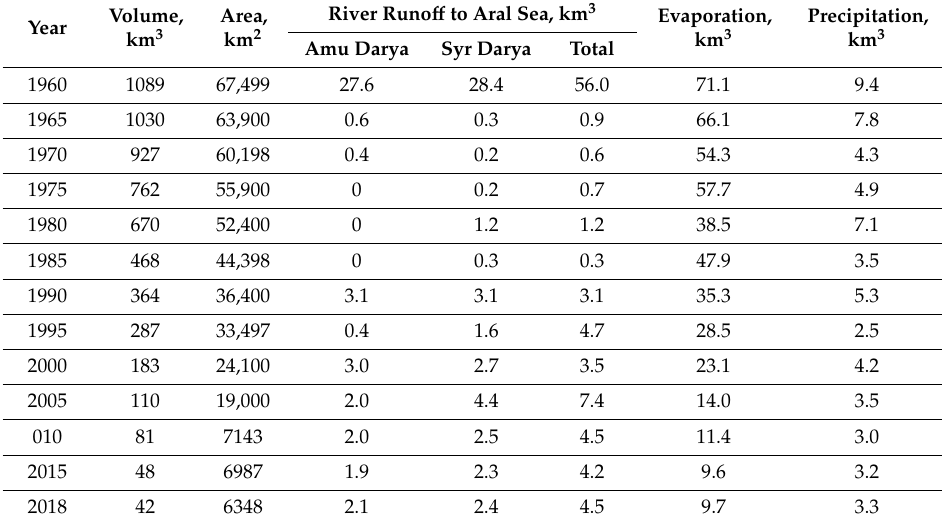
Precipitation, km 3 Amu Darya Syr Darya